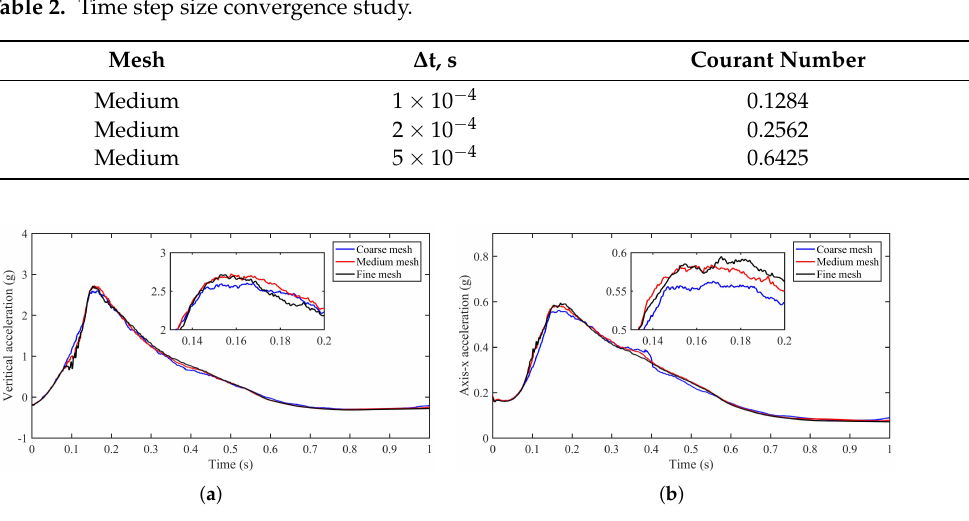
Figure 5. Results of mesh dependency study: ( a ) vertical acceleration; ( b ) axis-x/horizontal